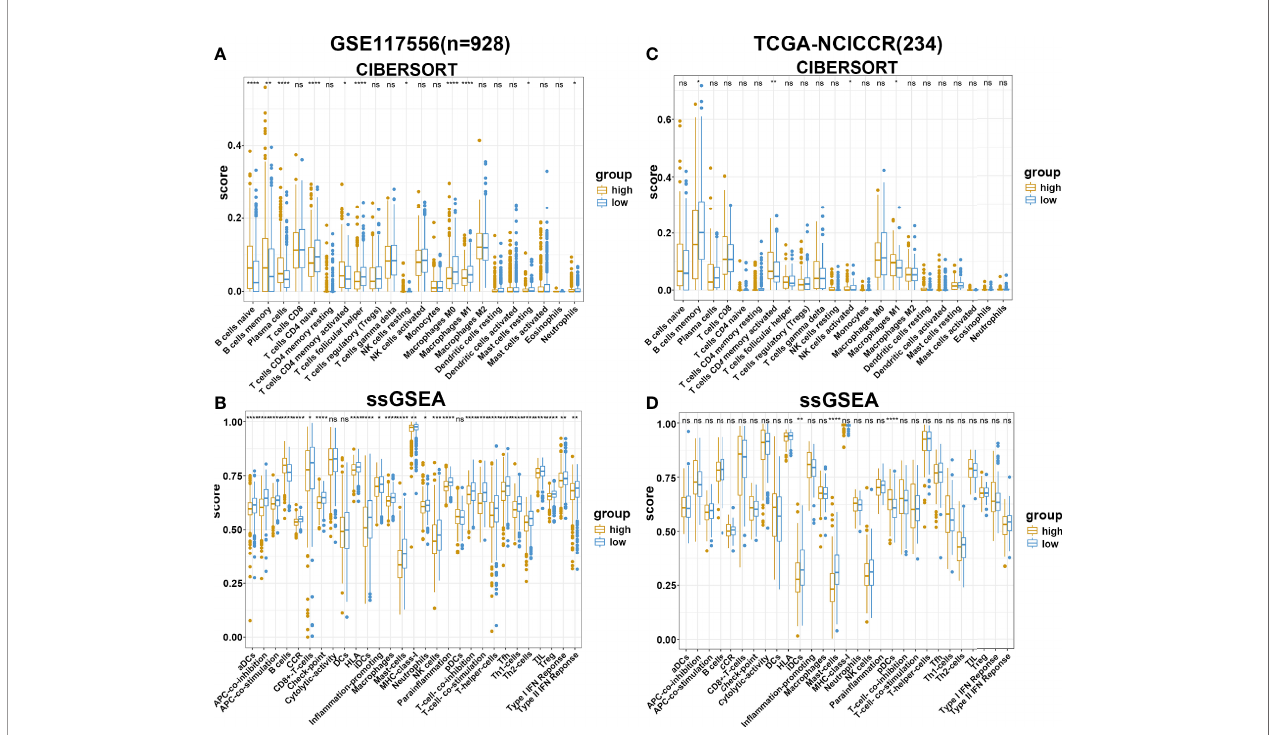
FIGURE 5 | Immune estimation in high- and low-risk groups. (A, B) The difference of immune in fi ltration in high- and low-risk groups estimated by CIBERSORT and ssGSEA in the GSE117556 datasets. (C, D) The difference of immune in fi ltration in high- and low-risk groups estimated by CIBERSORT and ssGSEA in TCGA- NCICCR datasets. ns, Not Signi fi cant; * P < 0.05; ** P < 0.01; *** P < 0.001; **** P <